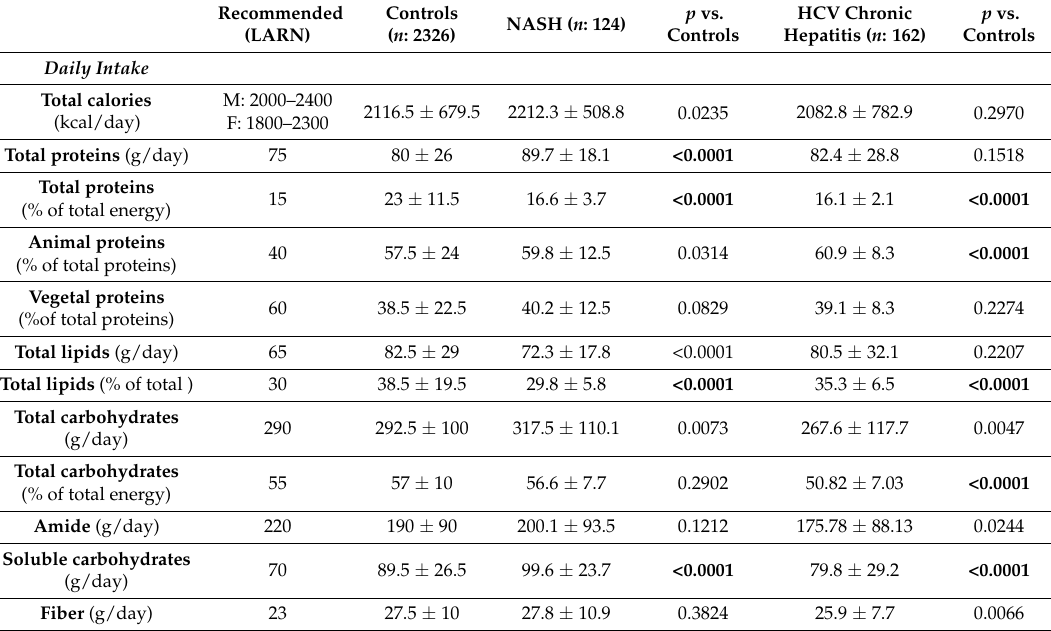
Table 2. Intake of macronutrients in study population (Mean ±